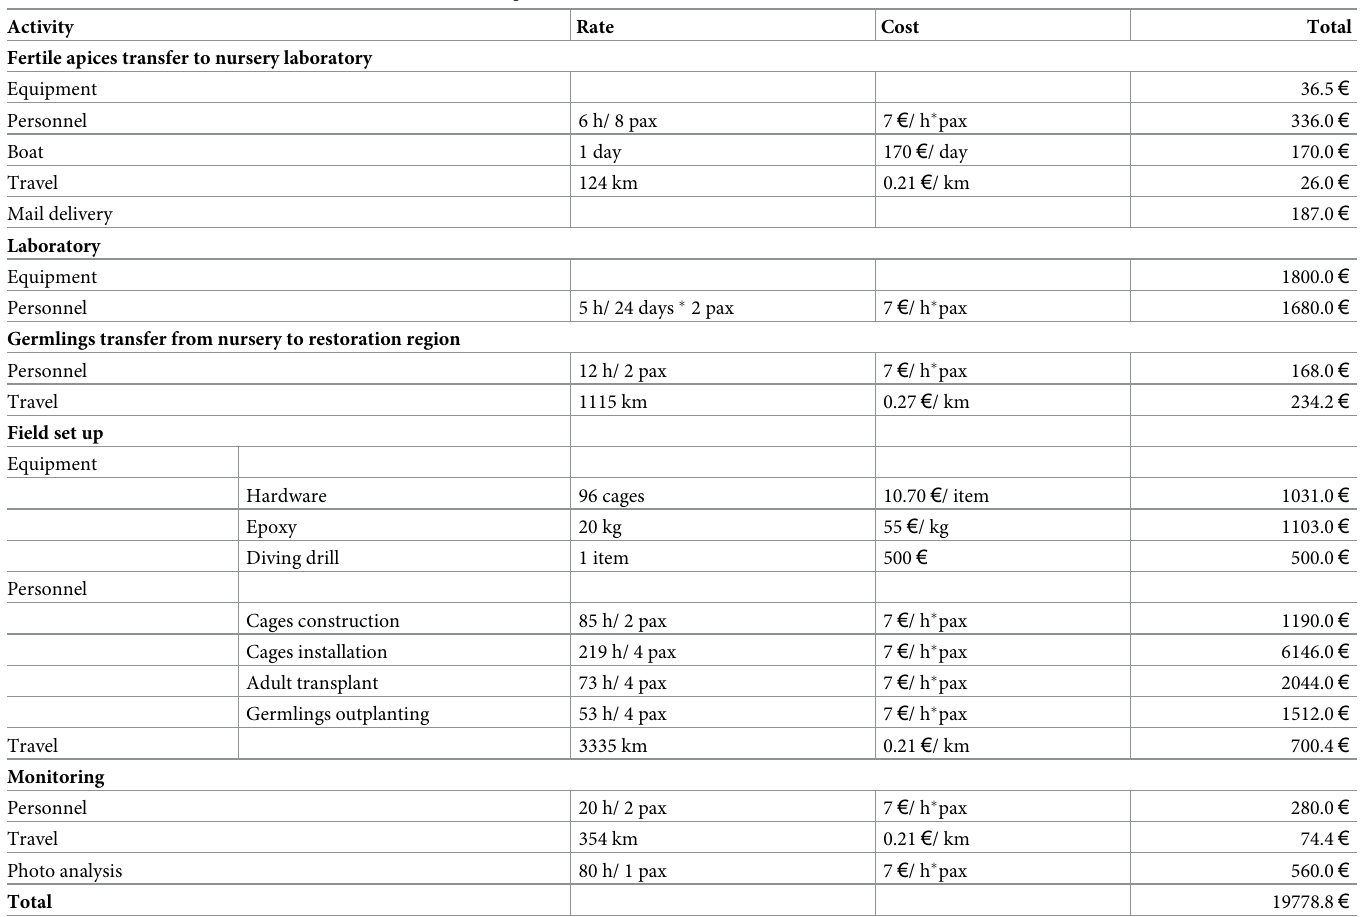
Table 1. Total costs of tested restoration intervention. Pax =